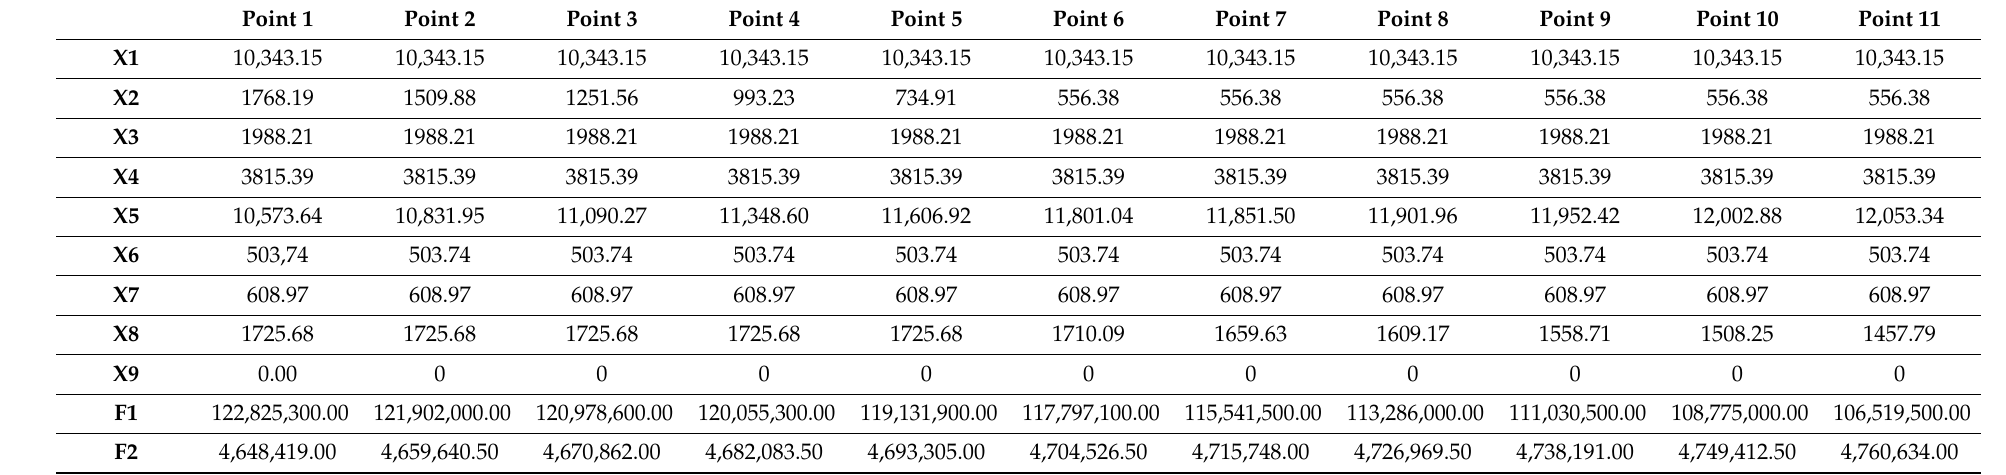
Table 8. Results of the Pareto front, optimal areas for economic and ecological benefits (F1 and F2,